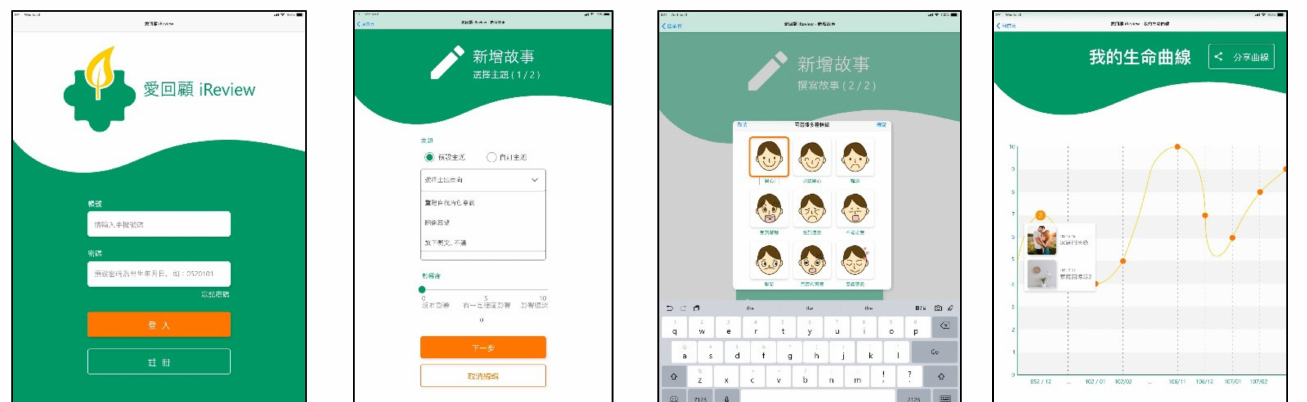
Figure 2. The interface of the i-Review interactive